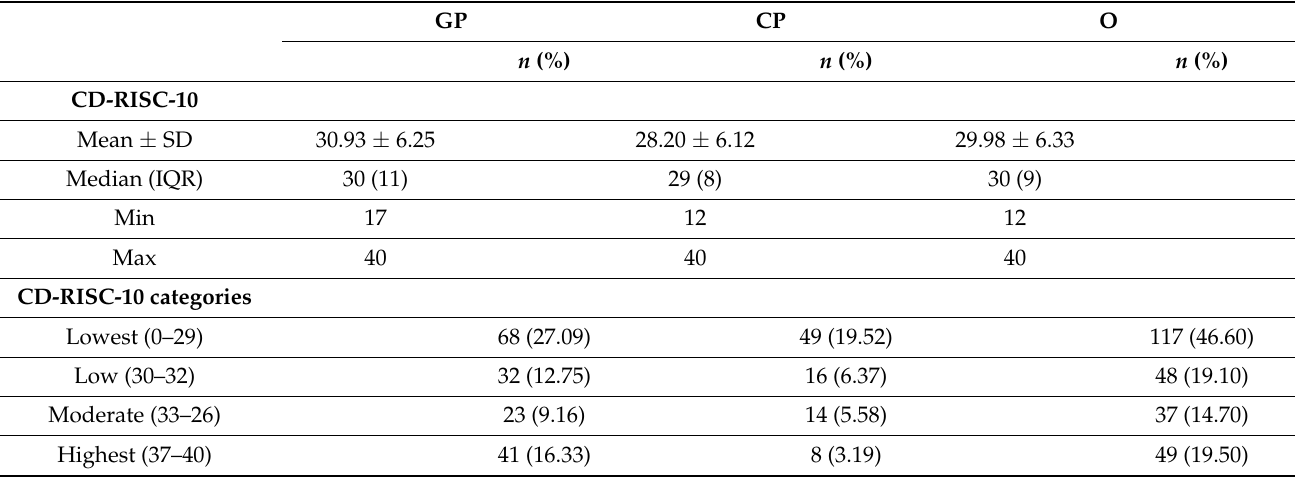
Table 2. Overall scores of CD-RISC-10 ( n = 251).